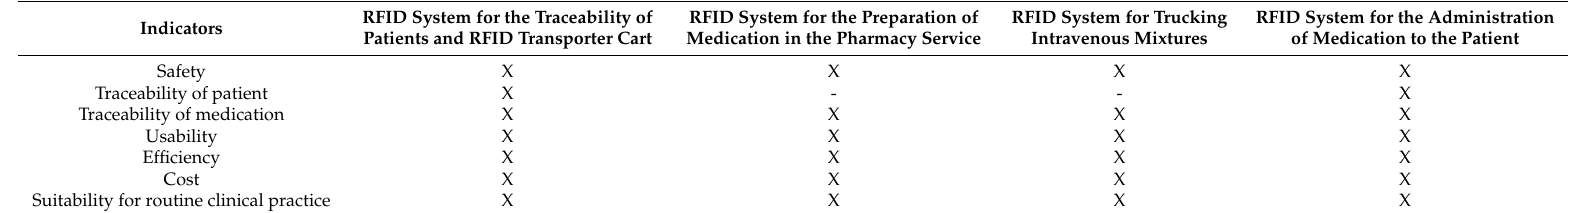
Table 4. RFID Systems which provide data for the indicators to evaluate.